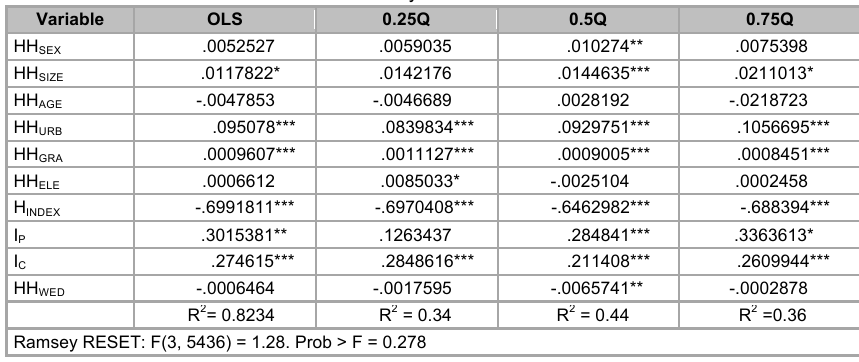
Demand elasticity estimates for